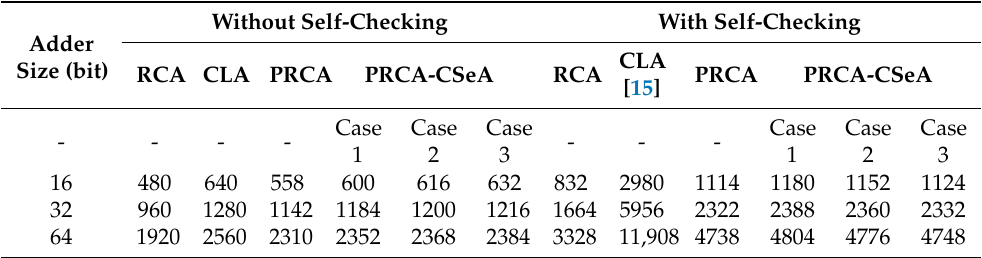
Table 2. Area overhead in terms of transistor count for RCA, CLA, proposed PRCA, and PRCA-CSeA combinations, with standard configurations along with their respective self-checking